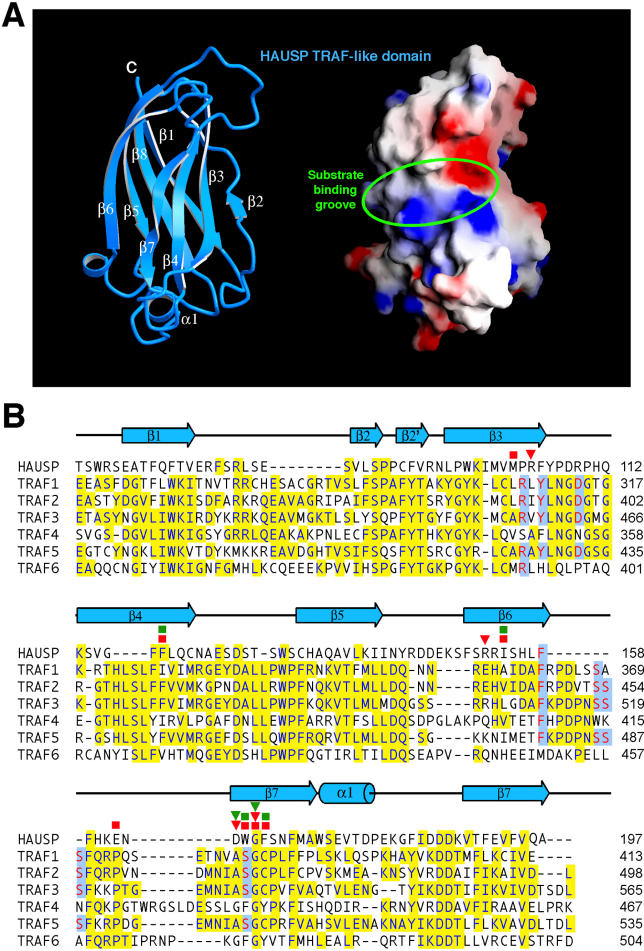
Structure of the HAUSP N-Terminal TRAF-Like Domain(A) Structure of the HAUSP TRAF-like domain in a ribbon diagram (left) and a surface representation (right). Secondary structural elements (left) and the putative substrate-binding groove (right) are labeled.(B) Sequence alignment of the HAUSP TRAF-like domain with other TRAF family members. Conserved residues are shown in yellow. Residues that interact with p53 through hydrogen bonds and van der Waals contacts are identified by green arrow heads and green squares, respectively. Residues that interact with MDM2 through hydrogen bonds and van der Waals contacts are indicated by red arrow heads and red squares, respectively. Conserved residues that are involved in binding to peptides in other TRAF family proteins, but not in HAUSP, are colored red and indicated by purple background.